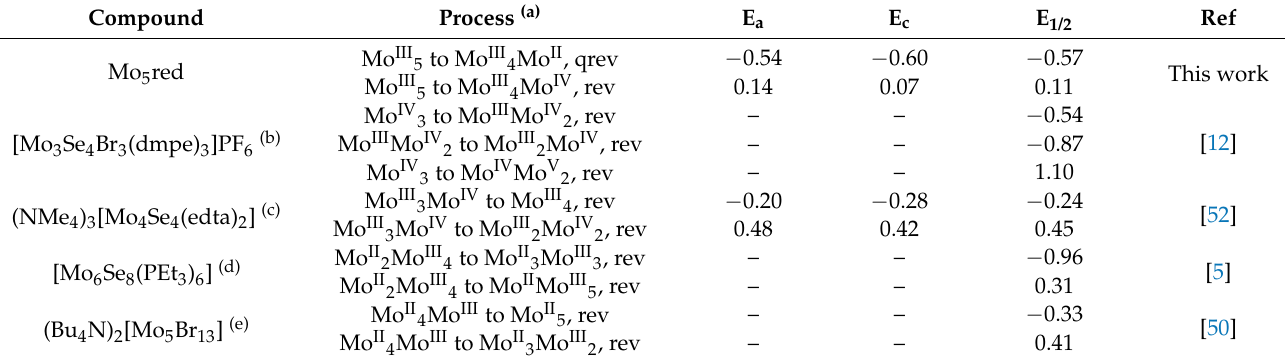
Table 4. Main electrochemical potentials (Volt vs. Ag/AgCl) for chalcogenide clusters in 0.1 M Bu 4 NClO 4 acetonitrile solution unless otherwise